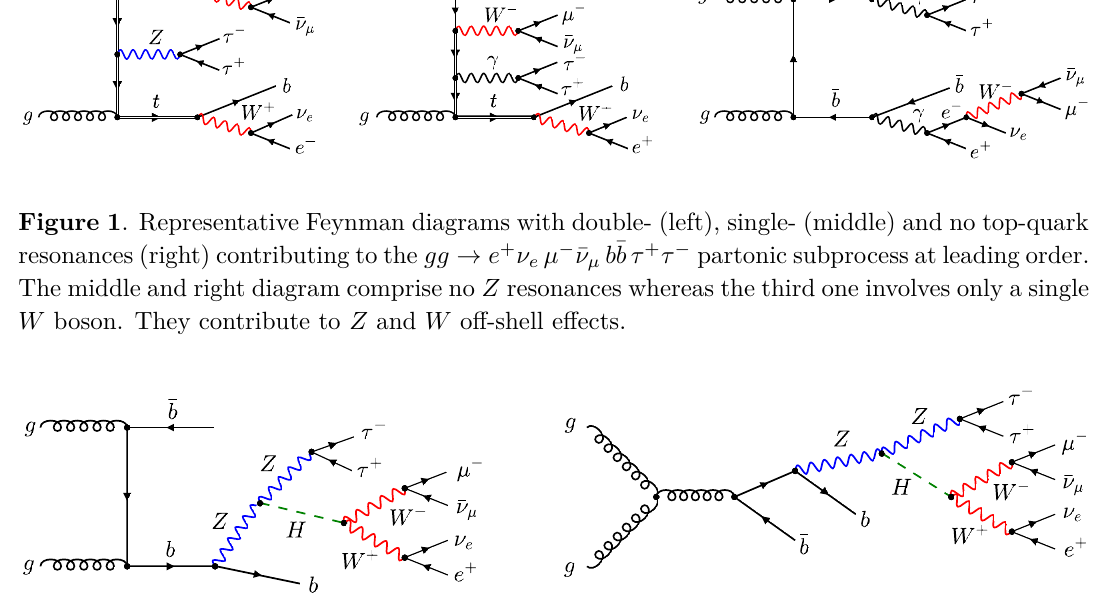
Figure 2 . Representative Feynman diagrams with the Higgs-boson-exchange contribution that appear in the gg → e + ν e µ − ¯ ν µ b ¯ b τ + τ − partonic subprocess at leading order even though the b quarks and τ ± leptons are treated as massless